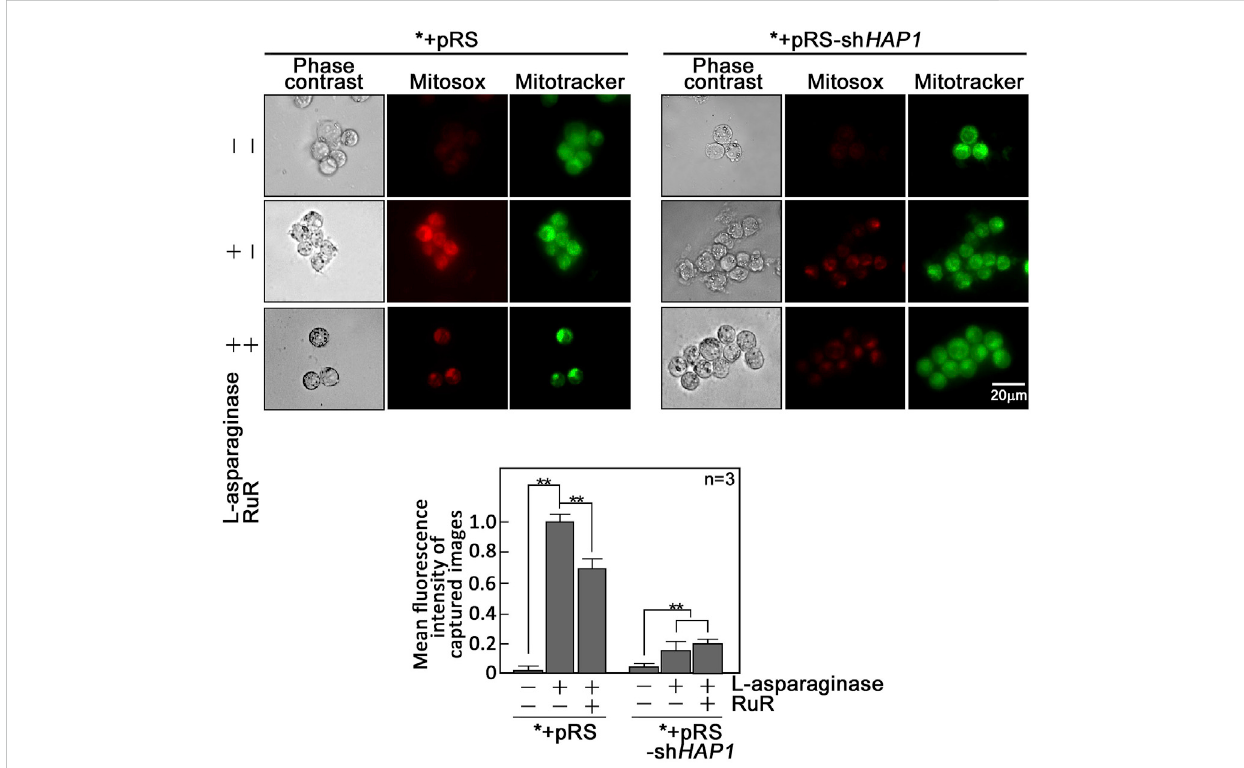
FIGURE 4 L-asparaginase induces an increase in mitochondrial ROS production. *+pRS and *+pRS-sh HAP1 cells pre-treated with RuR then stimulated with L-asparaginase were stained with MitoSOX red and MitoTracker green, and examined by microscopy. Cell images were acquired using an Olympus 1 × 71 inverted microscope at ×360 magni fi cation. Bar size = 20 µm. The bar graph shows mean fl uorescence intensity of captured images measured using the ImageJ software with values from cells treated with L-asparaginase alone normalized to 1. Values are means ± SEM from three independent experiments ( n = 3). ** p <